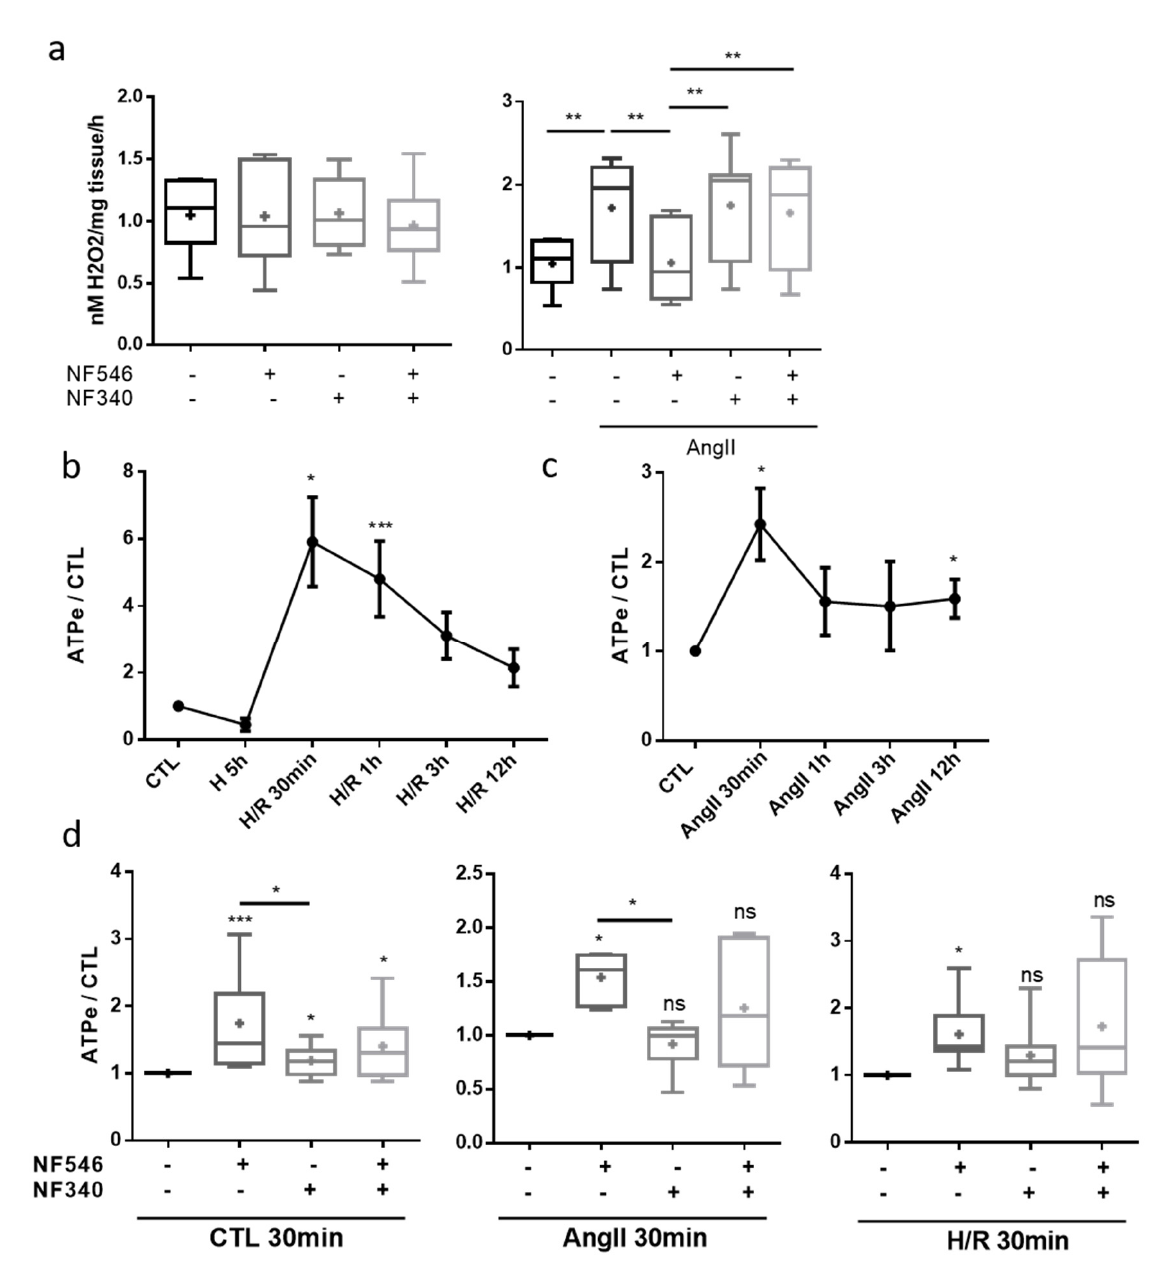
Figure 4. P2Y11 ligands regulate vascular stress factors release. ( a ) H 2 O 2 release by aortic rings was evaluated by FOX assay. Rings were incubated 30 min in FOX assay reagent with or without AngII (100 nM), NF546 (10 µM) or NF340 (10 µM). P2Y11 ligands NF546 and NF340 had no effect on H 2 O 2 release under the basal condition. AngII incubation increased H 2 O 2 release compared to the CTL group. NF546 incubation suppressed the effect of AngII by restoring basal H 2 O 2 level release (n = 9). ( b – d ) Extracellular ATP release was measured in HUVEC supernatants. HUVECs were subjected to 5 h hypoxia and supernatants were collected after several reoxygenation durations (30 min–12 h), or subjected to AngII incubation (30 min–12 h), in presence or absence of NF546 and/or NF340. ( b ) Hypoxia alone tended to decrease eATP secretion. Short times of reoxygenation (30 min–1 h) significantly increased eATP secretion, which progressively returned to the basal level. ( c ) Short exposures to AngII (30 min–1 h) increased eATP secretion, which progressively returned to the basal level. ( d ) After 30 min incubation, NF546 increased eATP secretion in the CTL (n = 11), H/R group (n = 7) and in the AngII group (n = 6). * p < 0.05, ** p < 0.01 and *** p < 0.01, compared to the CTL condition, if not indicated. Data given as mean ± SEM and box plot as median and mean + min to